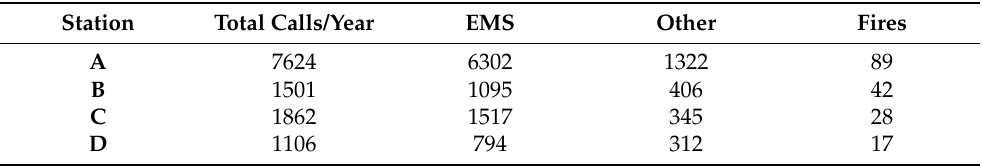
Table 8. Number of calls by type of call for FD2 during 2020.